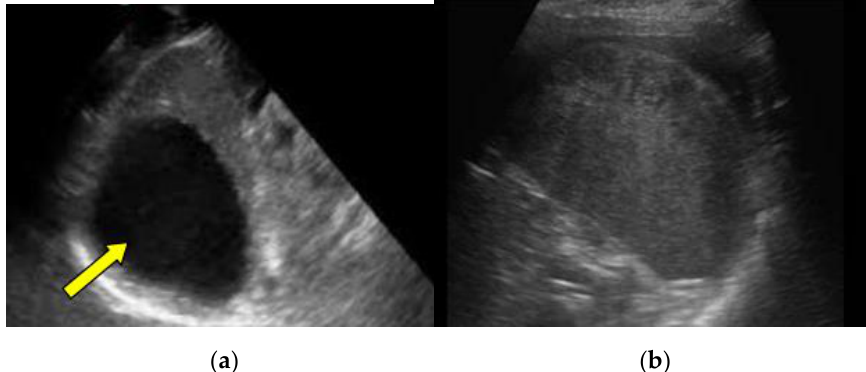
Figure 2. ( a ) A follow-up ultrasound examination, three months after the grade IV splenic injury (patient No. 16 in Table 3). Oblique ultrasound scans diagnosed regularly marginated hypoechoic pseudocyst measuring 50 × 55 mm 2 in size; ( b ) A transverse scans on a follow-up ultrasound examination, 30 days after trauma revealed subcapsular hematoma 52 × 23 mm 2 in size. Patient had grade III splenic injury after a fall from a standing height (patient No. 3 in Table 3). Complications were detected predominantly in male patients 62.5% (male to female ratio 10:6), with a median age 10.43 years (Table 3). All complications were detected on a